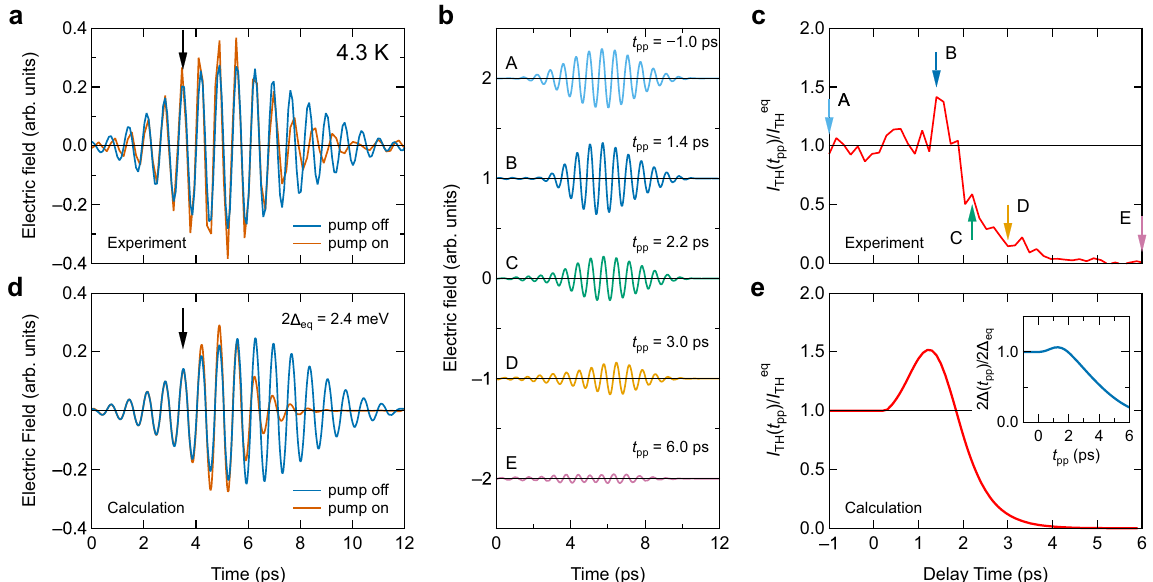
Fig. 4 Time-resolved THz-THG signal under the photoexcitation. a Waveform of the third harmonic (TH) component of the transmitted probe pulse. A black arrow at t = 3.5 ps indicates the arrival time of the pump pulse to the sample. The pump fl uence is 2.6 µ J cm − 2 . b TH component of the terahertz fi eld measured at fi xed pump – probe delay times, t pp , respectively. c Time evolution of the TH intensity, I TH t pp I eq . Arrows indicate pump – probe delay times at which the THz waveforms shown in b were measured. d Calculated waveform of the TH signal and e time TH evolution of the TH intensity, which correspond to the experimental results shown in a , c , respectively. Time evolution of the superconducting gap energy after the photoexcitation normalized by the gap energy in equilibrium, 2 Δ t